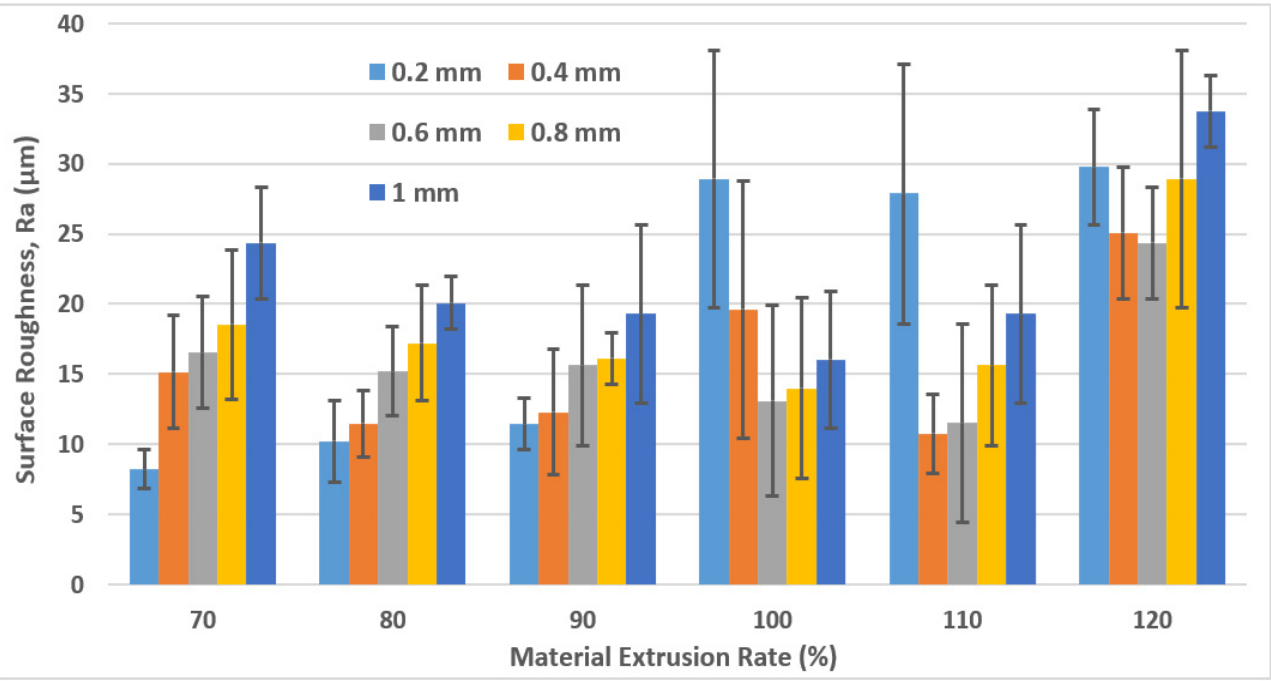
Figure 5. Surface roughness